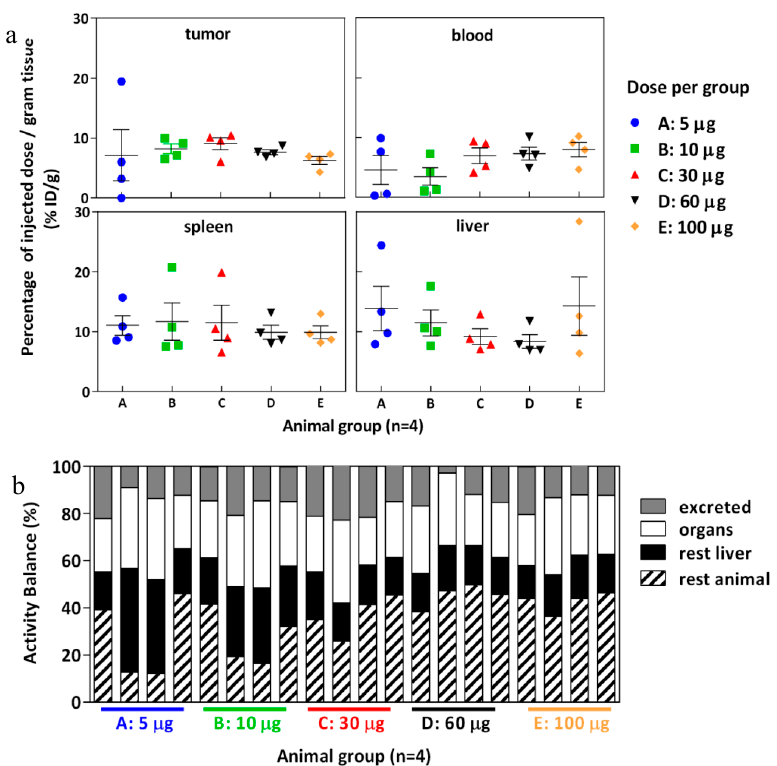
Figure 6. Biodistribution of [ 177 Lu]DOTA(SCN)-cG250 from conjugate C7 at 48 h using total protein dose adjusted between 5 and 100 µ g and 12 MBq per animal ( n = 4). ( a ) Organs: tumor, blood, spleen and liver. ( b ) Activity balance.